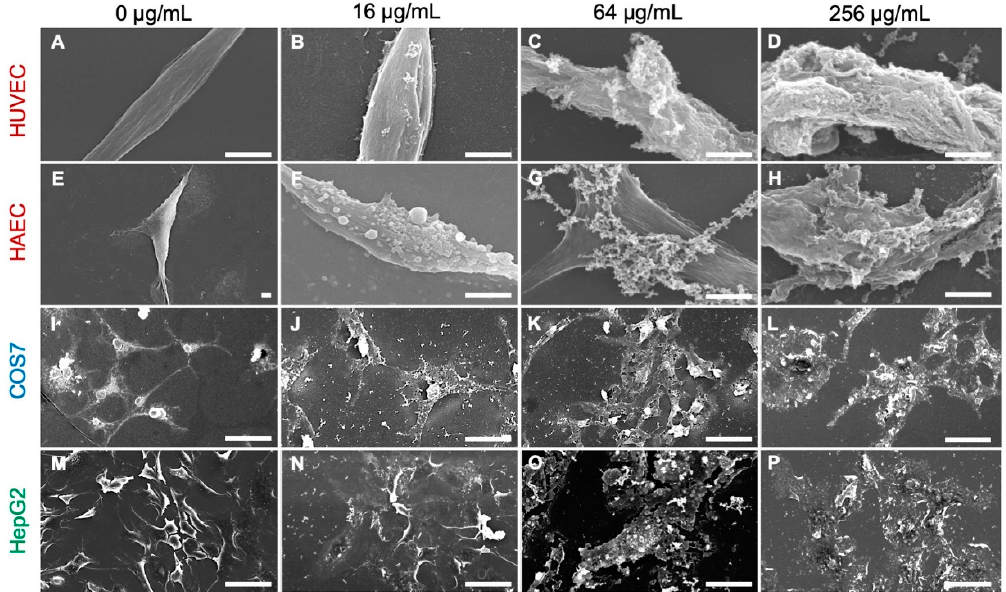
Figure 4. Scanning electron microscopy (SEM) images of mammalian cells following treatment with histone H3. Aliquots of HUVEC ( A – D ), HAEC ( E – H ), COS7 ( I – L ), or HepG2 ( M – P ) cells were incubated with histone H3 at 0, 32, 64, or 256 μ g/mL for 24 h at 37 °C and then examined using SEM. Cell membrane destruction is visible in each panel of histone H3-treated cells when compared with control cells (0 µ g/mL). Bars, 50 µ